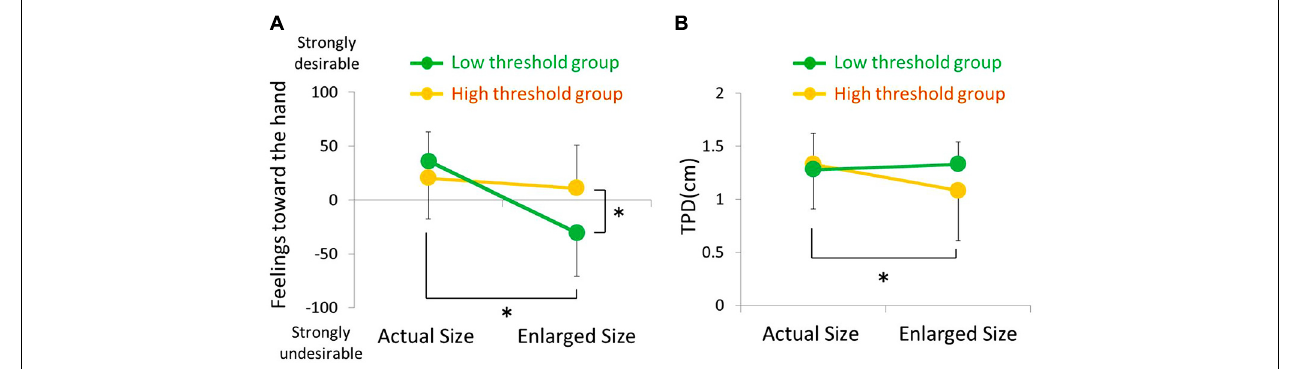
FIGURE 2 | Feelings toward the hand (A) andTPD (B) under actual size and enlarged size conditions in both the high threshold (orange bar) and low threshold (green bar) groups. Error bar is